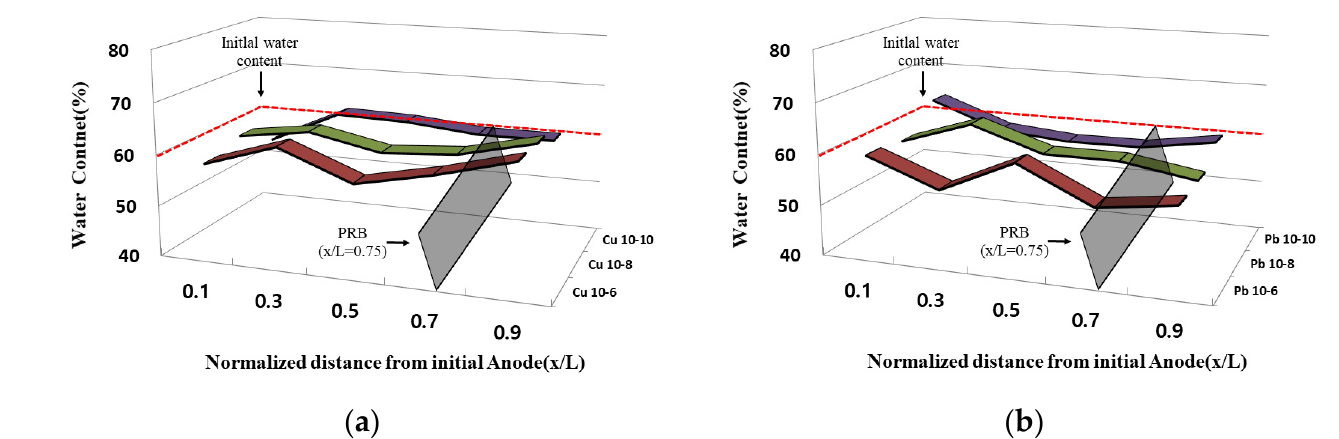
Figure 7. Water content after the end of the EK experiment: ( a ) copper; ( b ) lead.